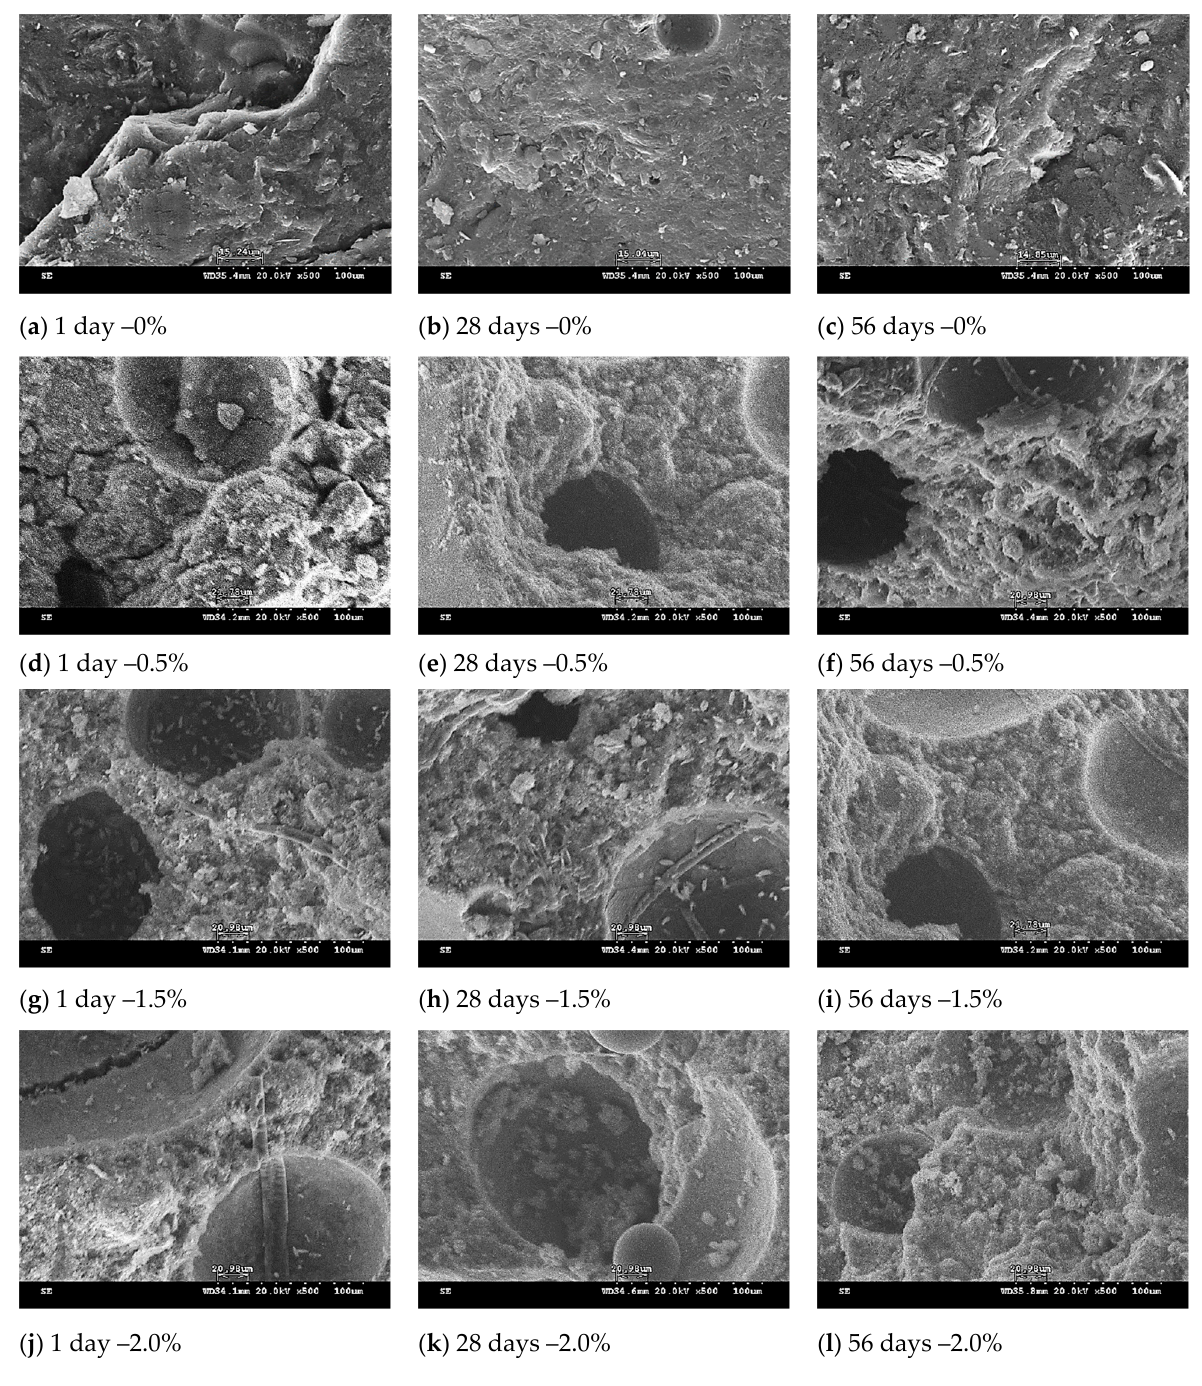
Figure 7. SEM micrograph of lightweight FGPs. (Replacement level = 10%). H 2 O 2 solution levels: ( a – c ) 0%; ( d – f ) 0.5%; ( g – i ) 1.5% and ( j – l )